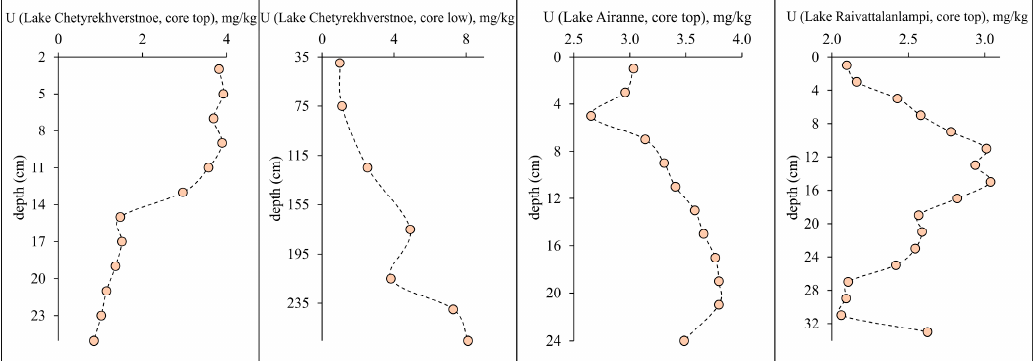
Figure 6. Vertical distribution of U in the sediments of lakes Chetyrekhverstnoe, Airanne and Raiva tt alanlampi.